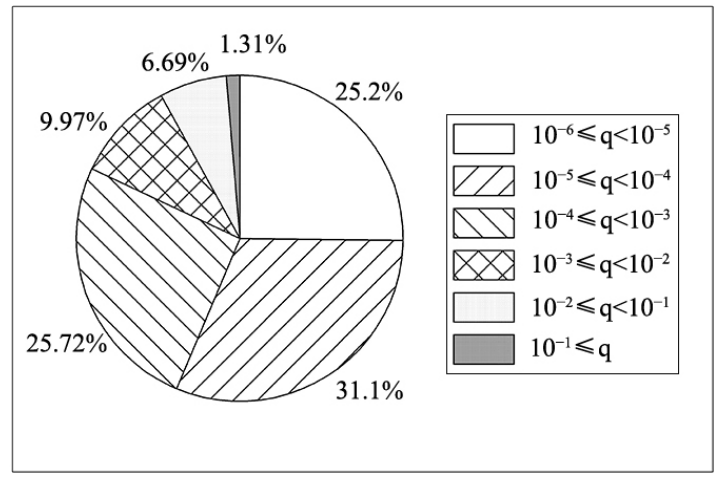
Figure 4. Distribution of all datasets.